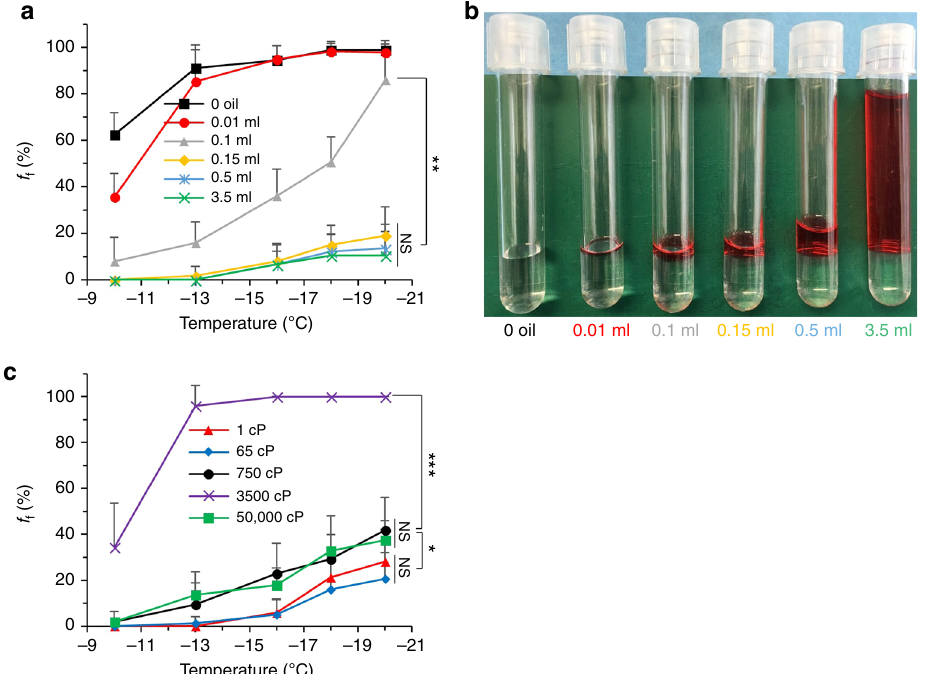
Fig. 2 Dependence of water freezing ef fi ciency on the volume and viscosity of sealing agents. a Effect of sealing oil (MO) volume on f f post 1-day DSC at different temperatures. n = 6, N = 70. b Side view of corresponding samples of a . MO includes Oil Red O for staining and imaging. 0 oil, 0.01 ml, 0.1 ml, 0.15 ml, 0.5 ml, and 3.5 ml indicate no seal, ring seal, partial seal, critical seal (just complete surface seal), standard seal, and over seal by MO, respectively. c Effect of viscosity of sealing agents on f f post 1-day DSC at − 16 °C. The sealing agents are hydroxy (OH) terminated polydimethylsiloxane (PDMS) of different chain lengths and viscosities. n = 5, N = 56. Error bars represent standard